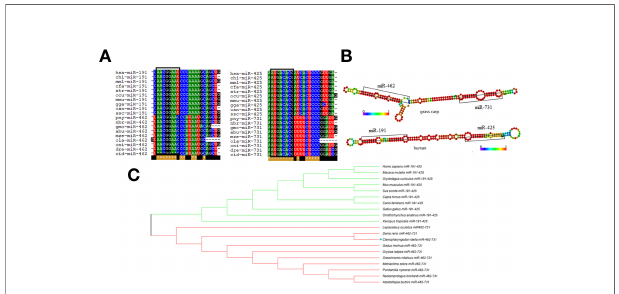
FIGURE 1 | Evolutionary analysis of miR-462-731. (A) Alignment analysis of different species of mature miRNA sequences was performed using BioEdit software. (B) Analysis of the precursor structures of miR-191-425 cluster and miR-462-731 cluster. (C) phylogenetic tree derived from alignment of miR-191- 425 and miR-462-731 sequences was constructed using the neighbor-joining (NJ) algorithm with bootstrapped 1000 times using the MEGA-X software.